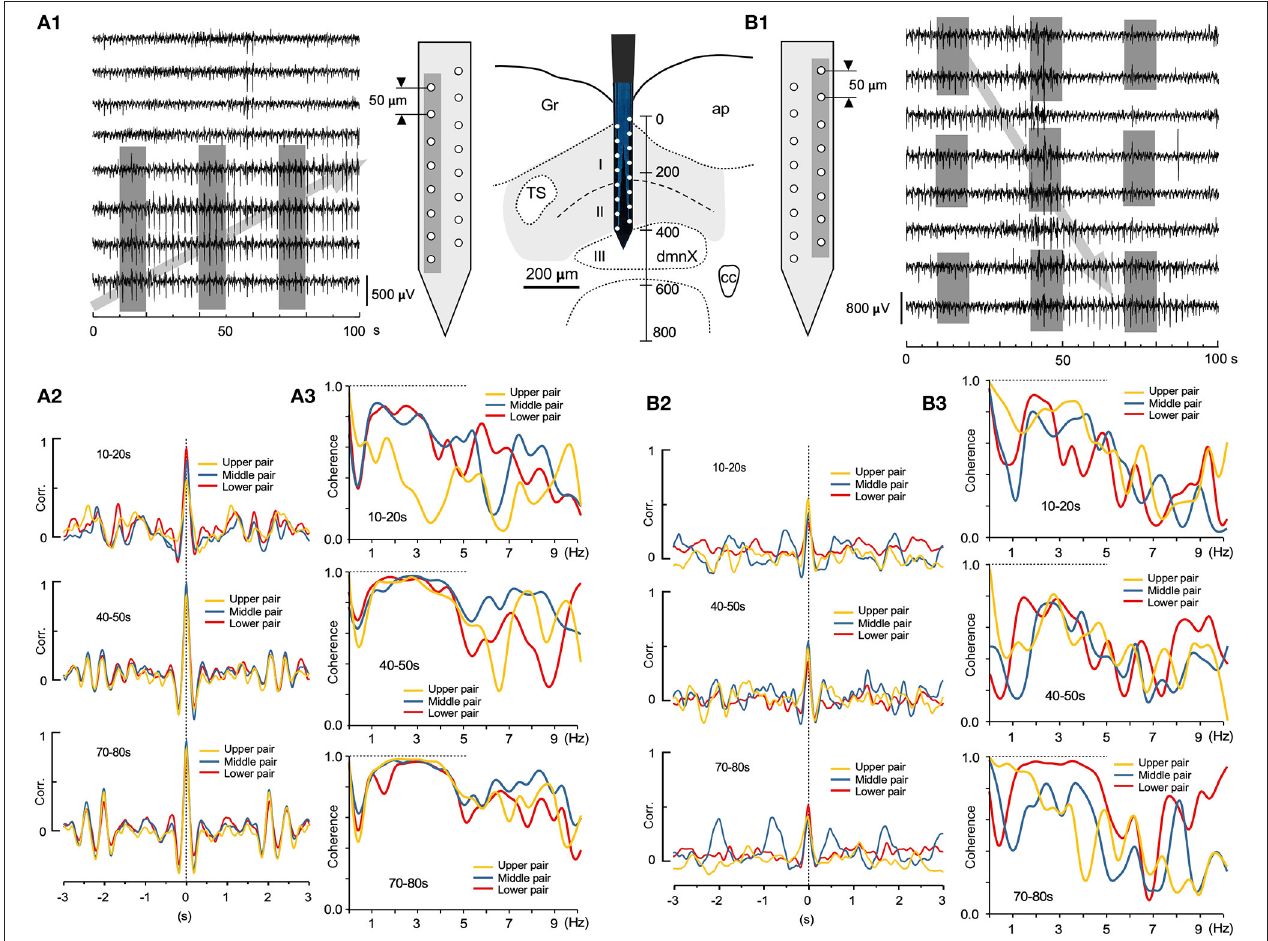
FIGURE 7 | Spatiotemporal dynamics of wave correlation (Corr.) and coherence of multiple local field potentials (LFPs). Wave Corr. and coherence of a 10s duration between LFPs recorded 30s apart from neighboring pairs of electrodes (gray shades in A1 and B1 ) across the depth of the vagal complex. Note a tendency of temporally-upward (gray arrow in A1 ) or -downward (gray arrow in B1 ) increases in Corr. (3 colored pairs in A2,B2 ) and an apparent higher coherence during 1–5Hz frequency range (3 colored pairs in A3,B3